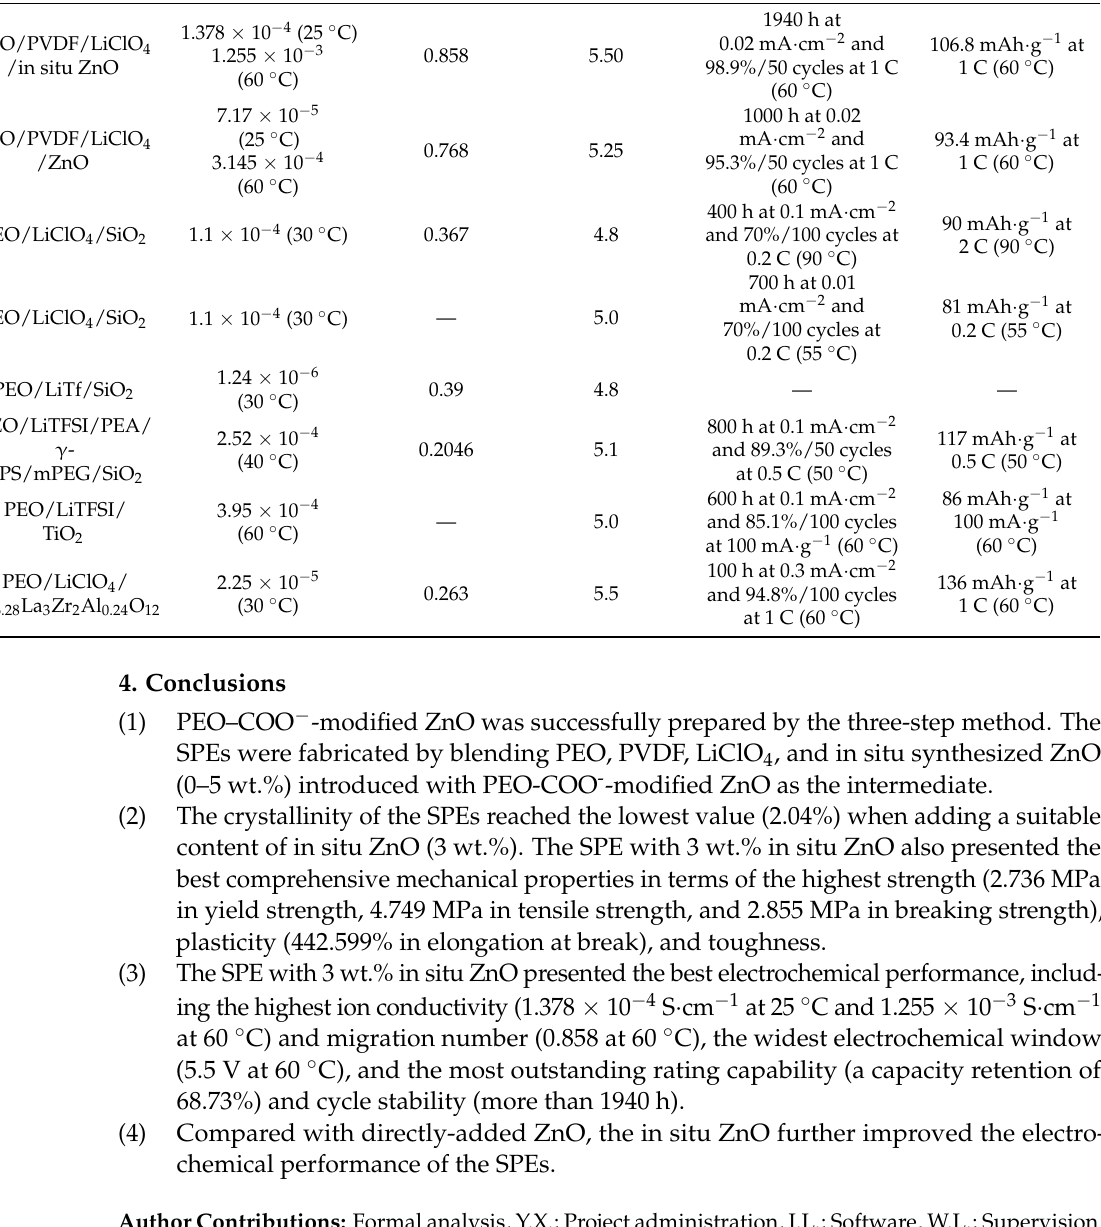
Table 6. The electrochemical performance of the SPEs reported in references in the last five years.